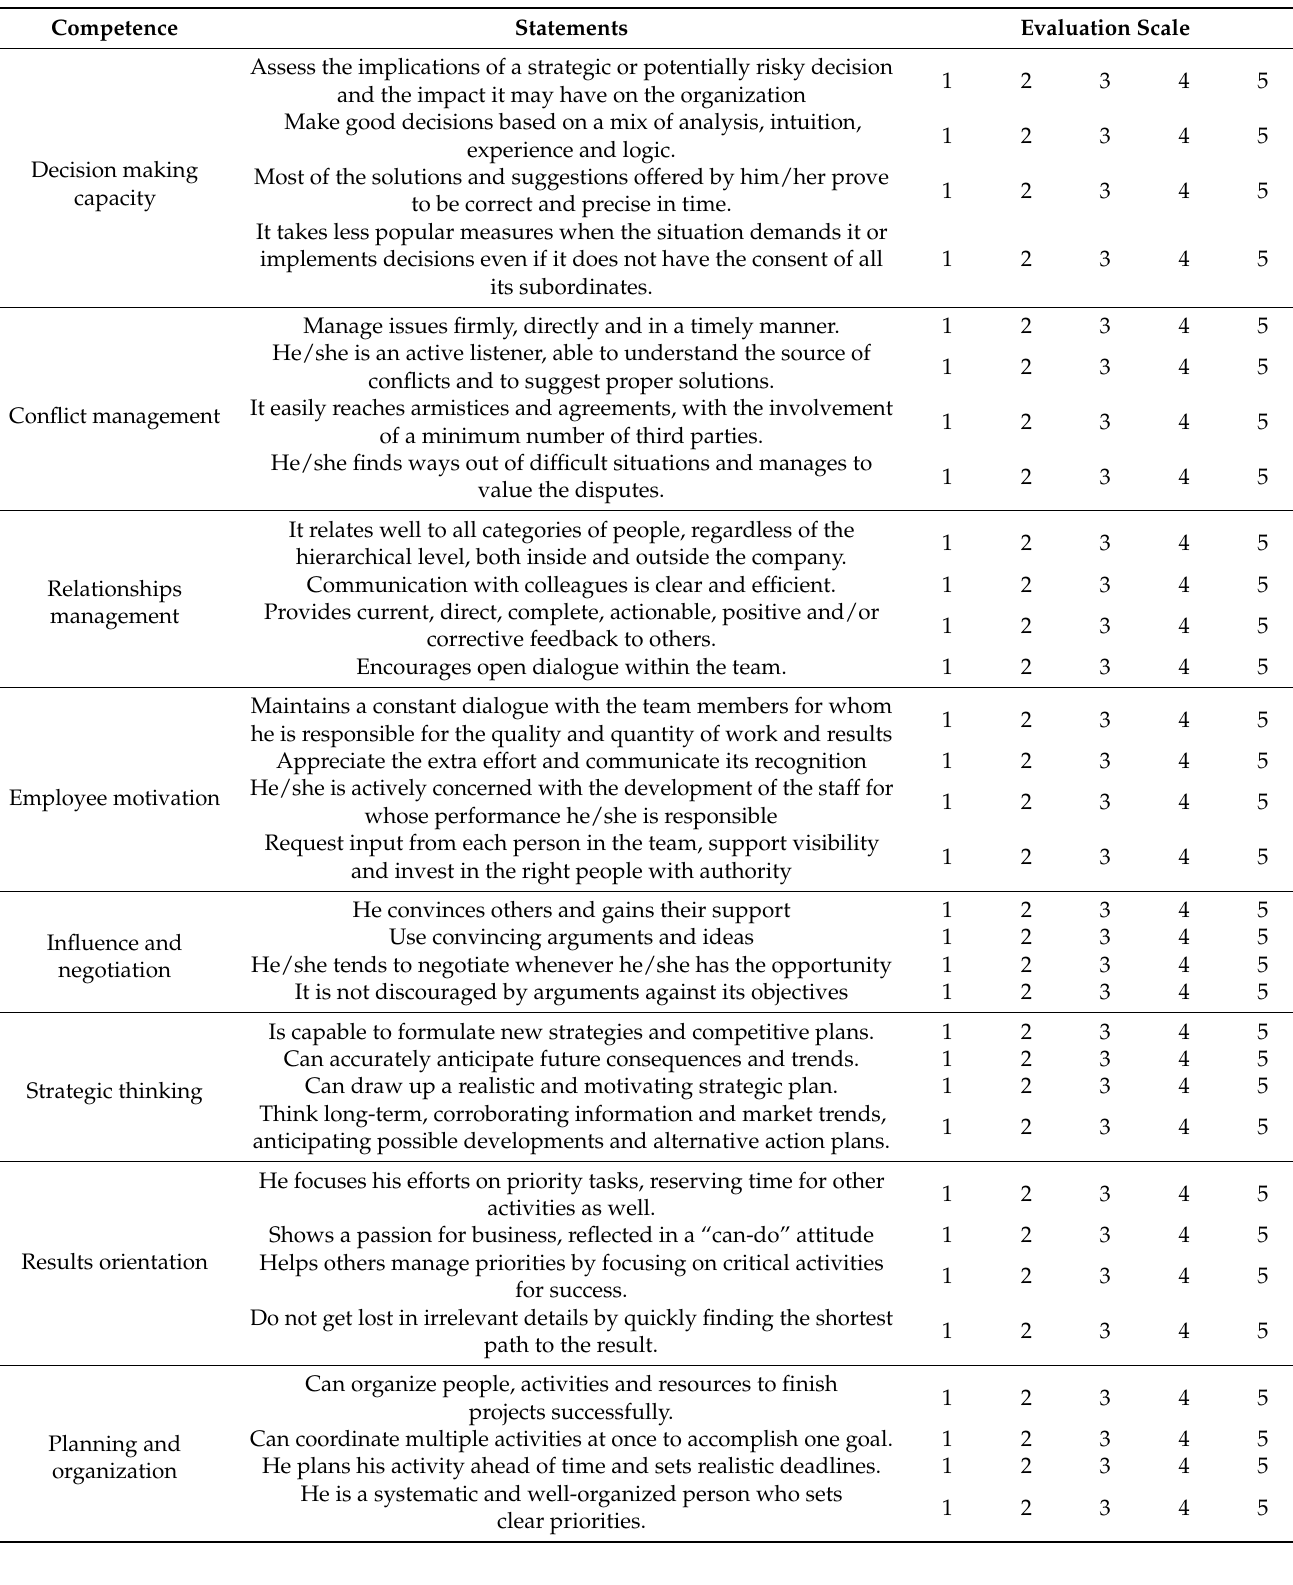
Table A1. The 360 feedback form for measuring a manager’s performance